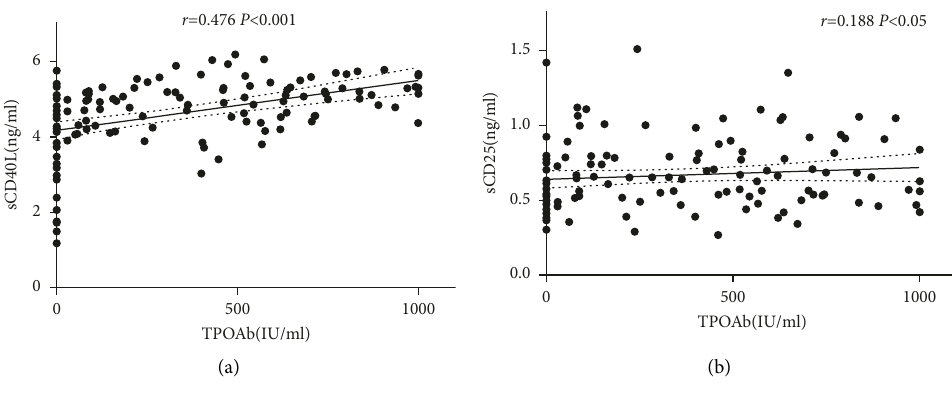
Figure 3: Correlation analysis between sCD40L, sCD25, and TPOAb titers. Table 2: The comparison of baseline and laboratory parameters of participants with or without GDM in early pregnancy. Variables